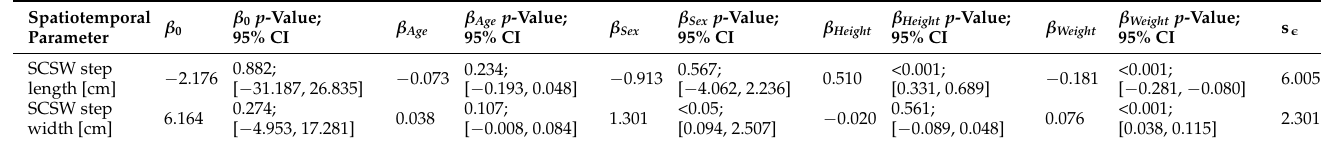
Table 4. Linear model coefficients describing associations with confounders age, sex, height, and weight. Abbreviations: CI: confidence interval; SCSW: short comfortable speed walk; s (cid:15) : standard deviation of residuals.